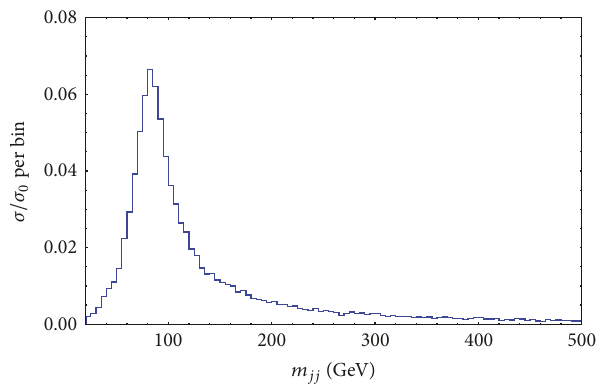
Figure 24: Invariant mass distribution of the lepton plus two-jet systems (𝑚 ℓ𝑗𝑗 ) from the ℓ + MET + 2𝑗 final state coming from ggF process. The lepton plus two-jet system shows a peak around the RHN mass (𝑚 𝑁 ) at the 13TeV